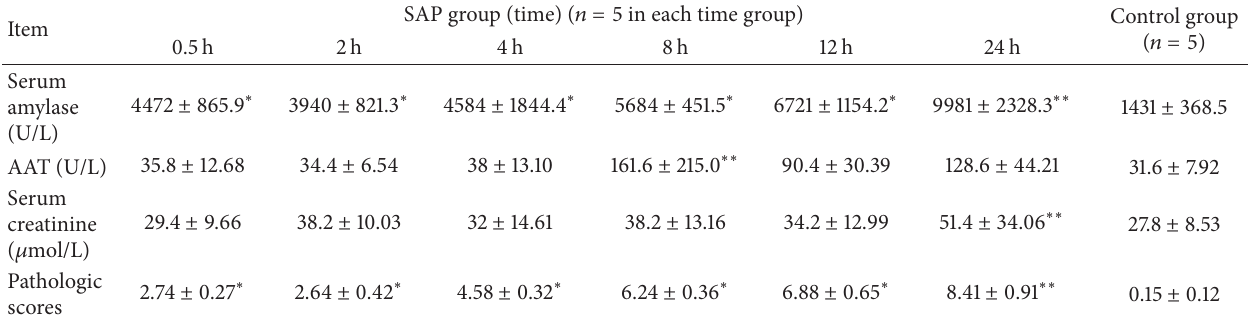
Table 1: The level of serum amylase, AAT, serum creatinine, and pathologic scores in SAP group and control group ( 𝑥 ± 𝑠 ).